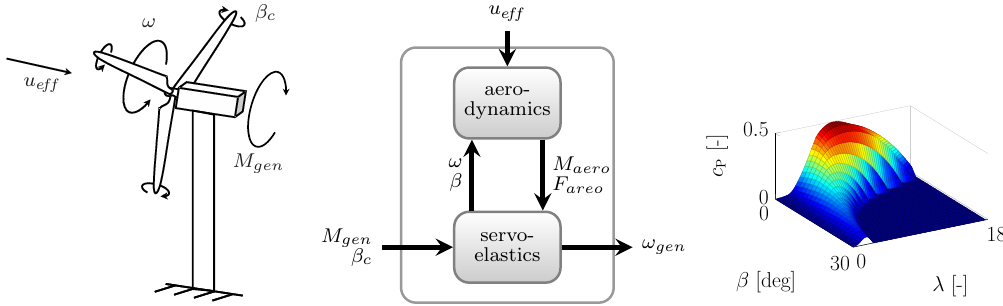
Figure 6. Degrees of freedom for the reduced nonlinear model ( left ). Control and disturbance inputs to the modules of the reduced model ( center ). Look-up tables of power coefficients ( right